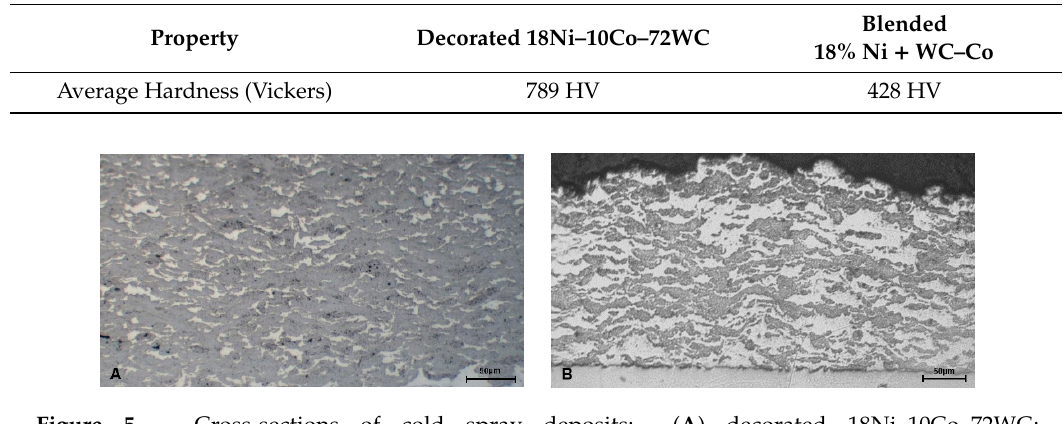
Table 5. Comparison of coating hardness for tungsten carbide (WC)-based powders manufactured using di ff erent methods.